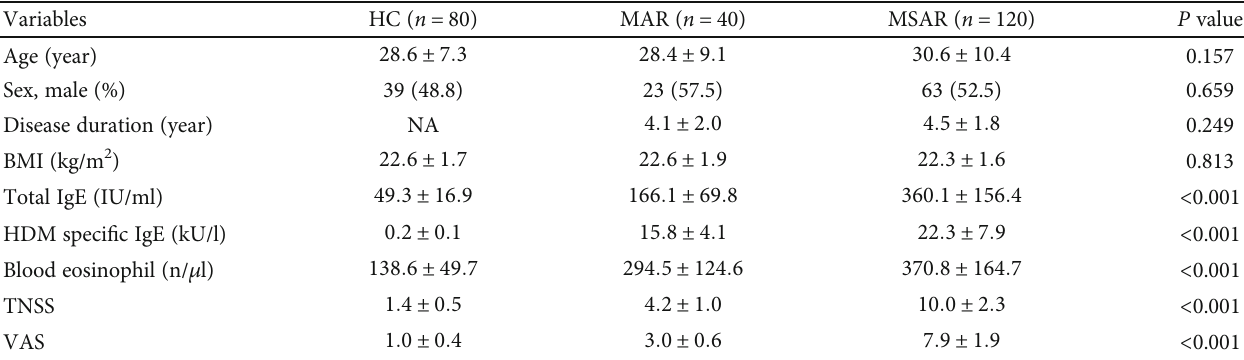
Table 1: The demographic and clinical characteristics of